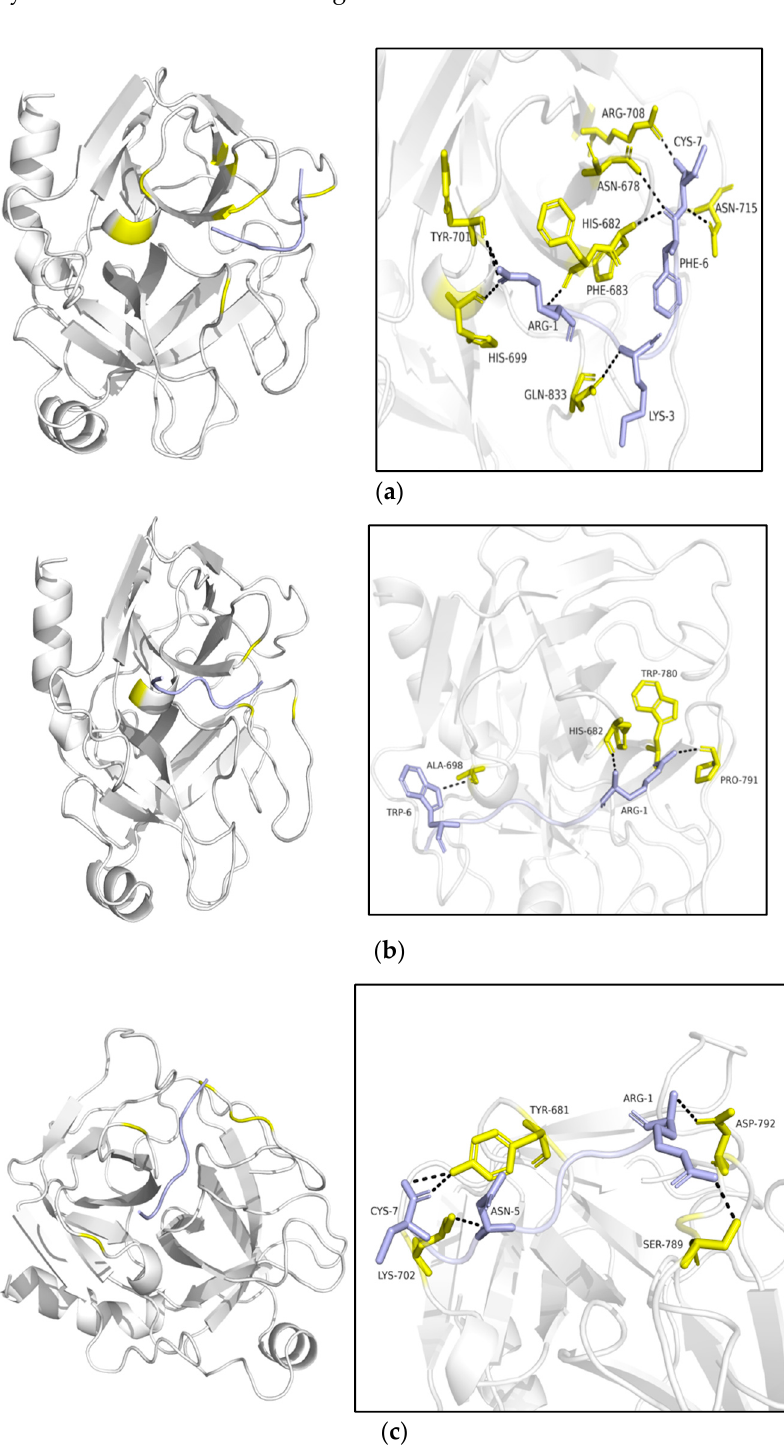
Figure 3. Visualization of the mimetic molecular docking of the combination between the inhibitors and trypsin (bovine pancreas proteasome, PDB ID: 1S0Q) by HDOCK. Ligands were highlighted in blue, and the receptor was represented in grey. ( a ) interaction between AH-798 and trypsin; ( b ) interaction between AH-837 and trypsin; ( c ) interaction between AH-884 and trypsin. Residues involved in the combination are marked with yellow (receptor) and blue (ligand), and the hydrogen bonds are expressed by black dashed lines among the residues. Table 2. Comparison of docking scores of selected sequences calculated by HDOCK.